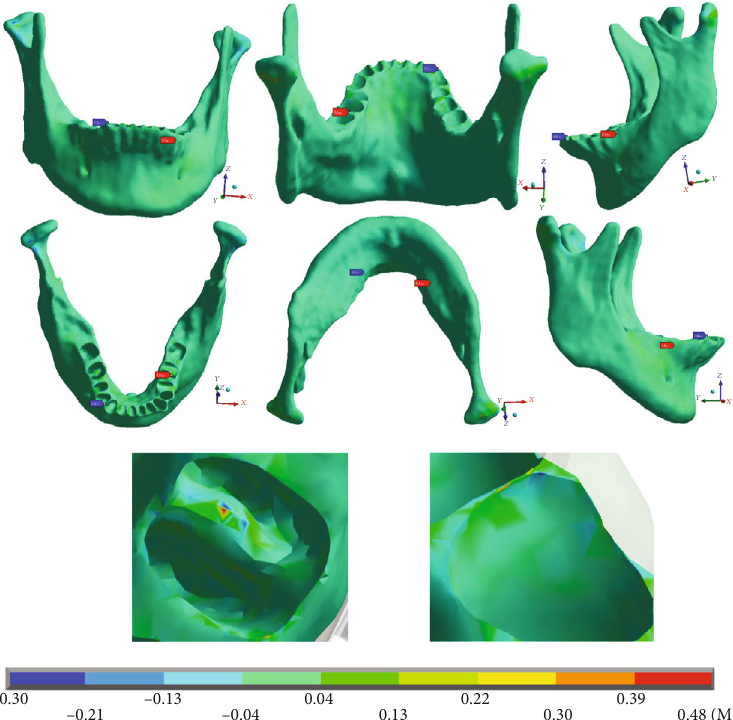
Figure 16: Normal stresses in X , mandibular bone. The red marker indicates the maximum stresses, and the blue marker indicates the minor